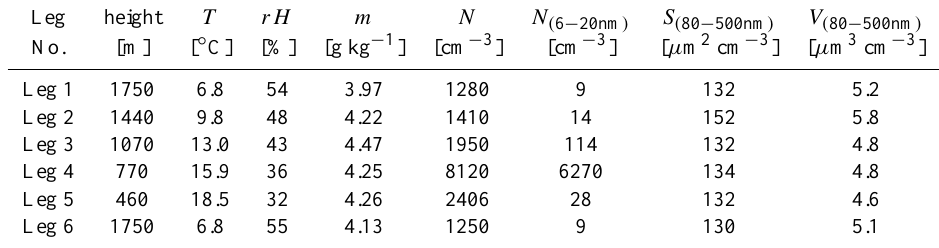
Table 2. Mean characteristics of horizontal flight legs 1–6.